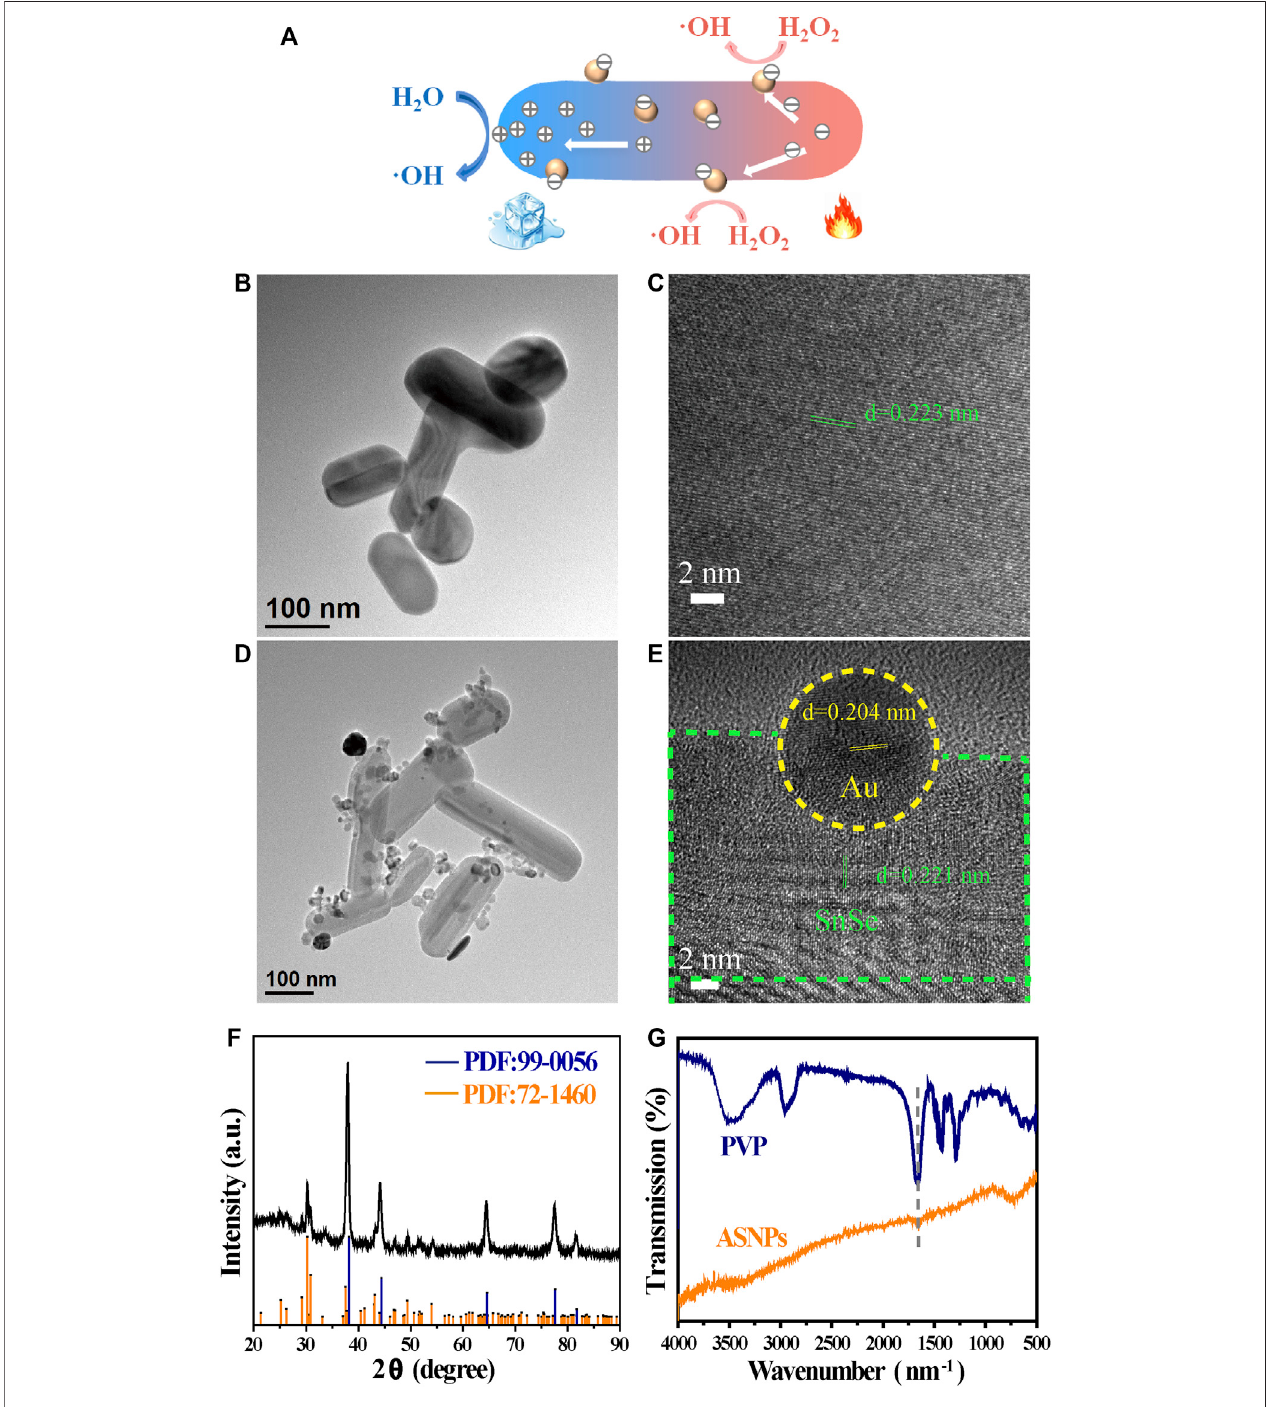
FIGURE 1 | Description and characterization of SnSe and ASNPs. (A) Schematic illustration of ASNPs generating · OH in the PEDT process. (B) TEM and (C) HRTEM images of SnSe. (D) TEM and (E) HRTEM images of ASNPs. (F) XRD patterns and (G) FT-IR spectra of ASNPs.